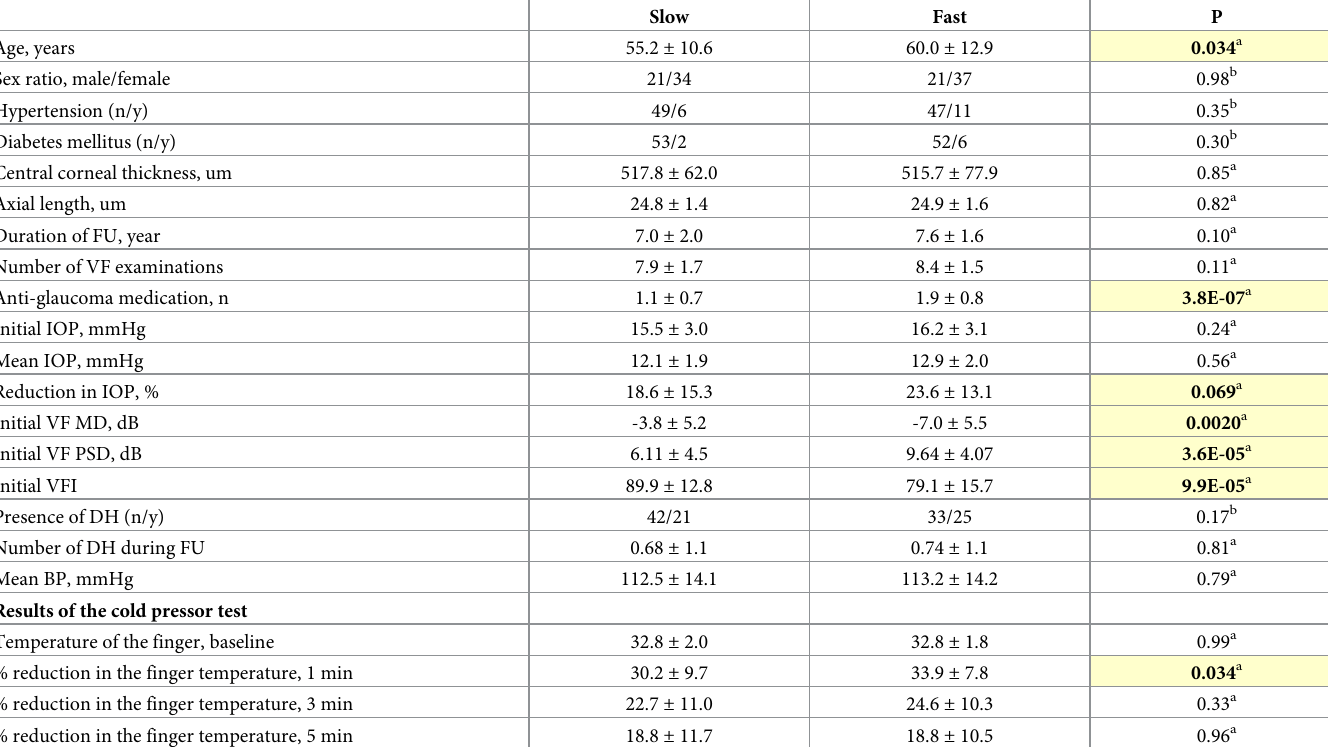
Table 4. Comparison of clinical characteristics and cold pressor test results among patients with slow and fast VF